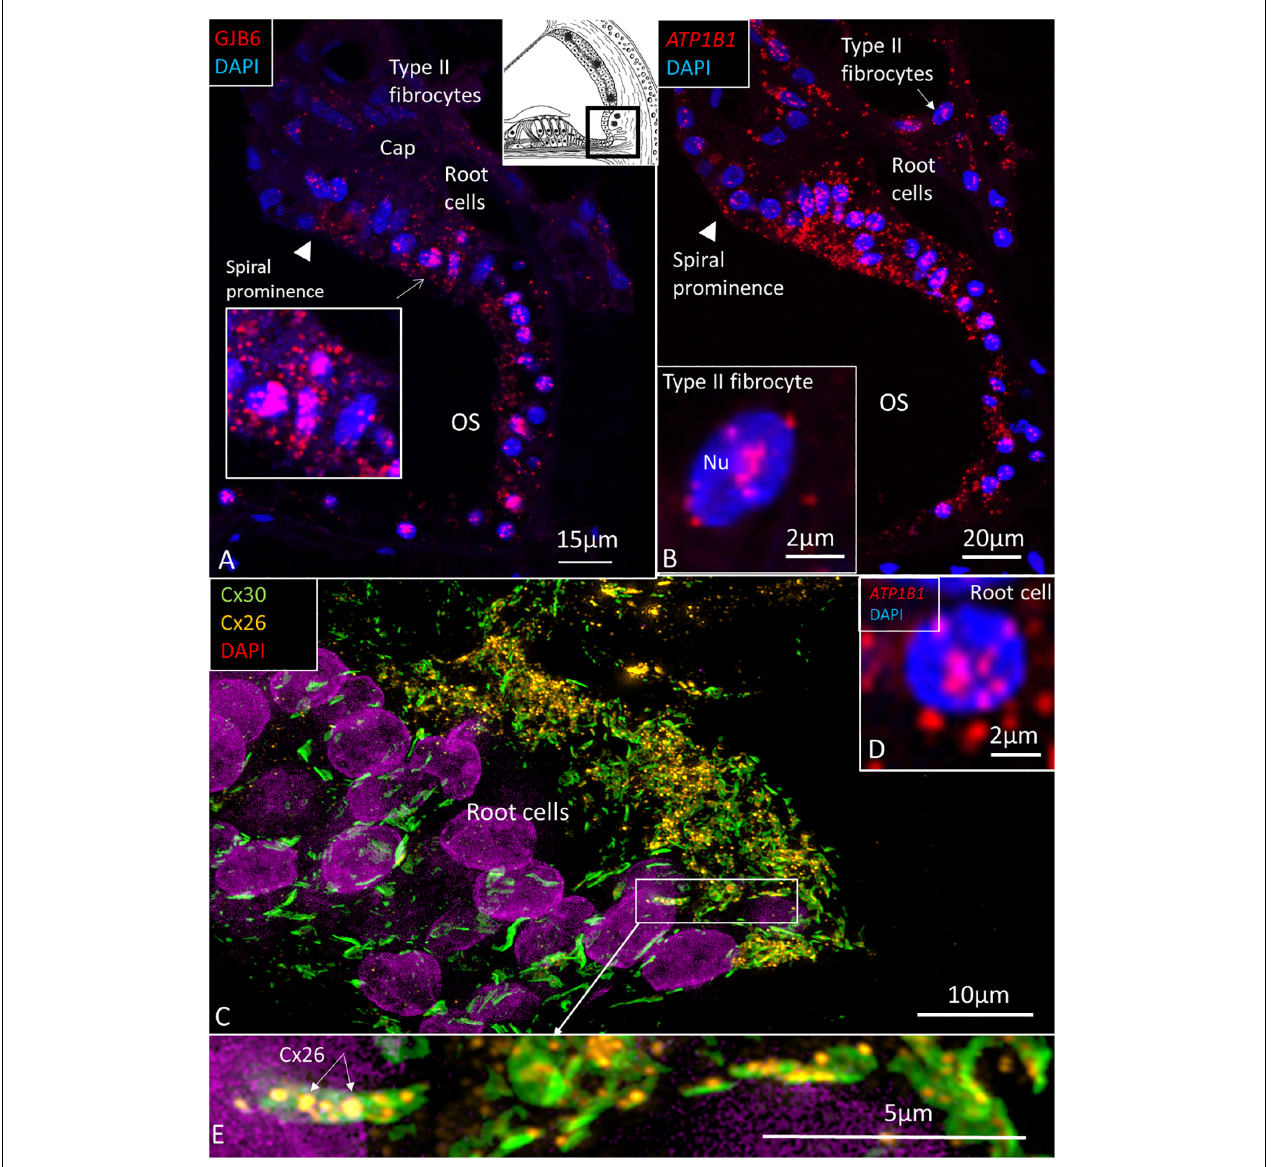
FIGURE 5 | (A) The human outer sulcus epithelium demonstrates many red puncta representing GJB6 transcripts. These are also seen in type II fibrocytes. Inset shows root cells at higher magnification. (B) ATP1B1 gene transcripts are also expressed in the outer sulcus epithelium and in type II fibrocytes. Inset shows a type II fibrocyte at higher magnification with mRNA transcripts located in the nucleus (Nu) and at nuclear pore regions. (C) SR-SIM shows expression of Cx26 and Cx30 in the root cells. Inset (D) shows a root cell expressing ATP1B1 . Framed area is magnified in (E) , showing several large Cx30 GJ plaques in the root cells and associated Cx26 plaques (arrows). OS, outer sulcus; Cap,